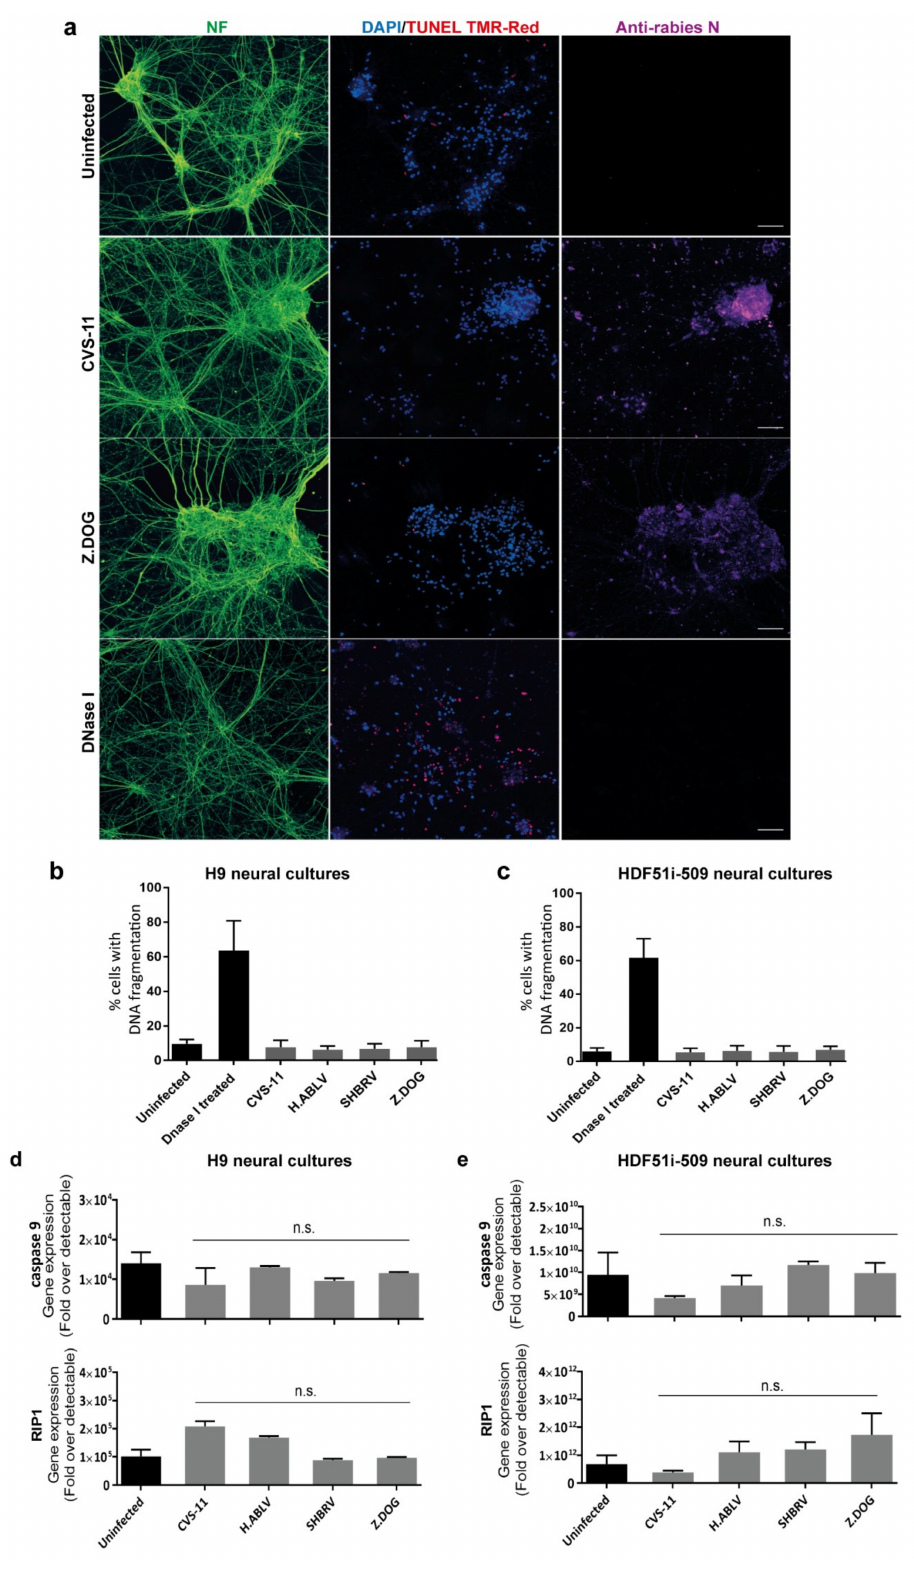
Figure 3. Lack of apoptosis in stem cell-derived human neural cultures infected with lyssavirus strains. HDF51i-509-NPCs and H9-NPCs were di ff erentiated for 24 days and 29 days, respectively. These neural cultures were infected with di ff erent lyssavirus strains for 72 h at virus:cell ratio of 1 and examined